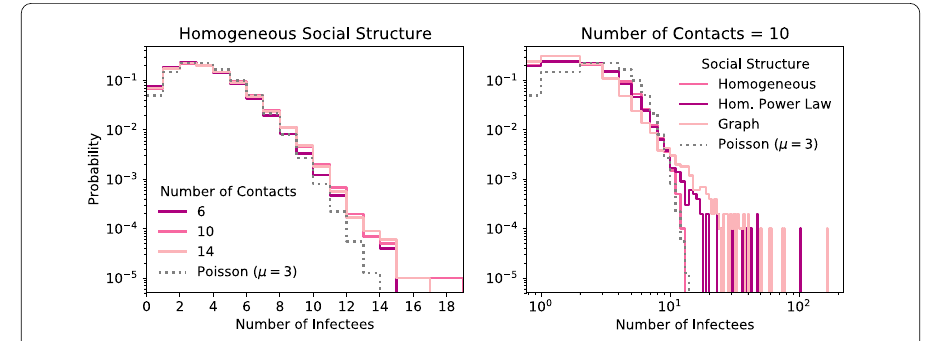
Figure 2 The distribution of the number of people a carrier infects (Eq. (8)) for 3 combinations of n c (the mean number of contacts per day) and β i (the average transmission probability per day) that result in R 0 = 3 (see Tab. 1) (left) and for a fixed n c but different social structures (right). Default values for the infection probability curve are used, η as = 1, and no interventions are applied. Compared to a Poisson distribution